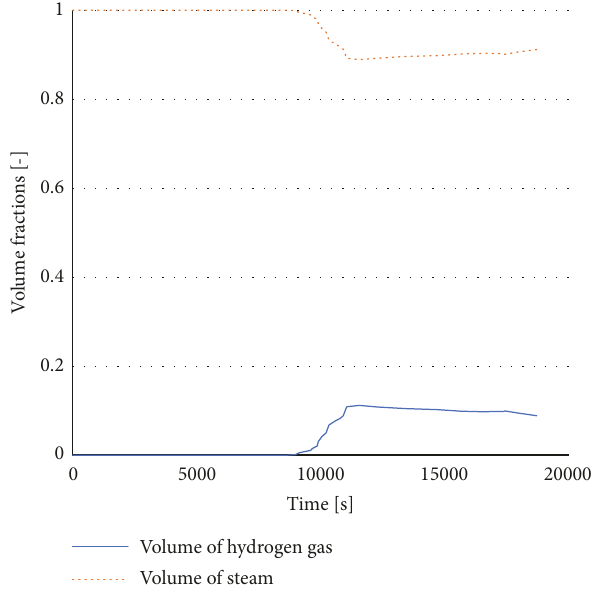
Figure 7: Volume fractions of hydrogen gas and steam in ART Mod 2.